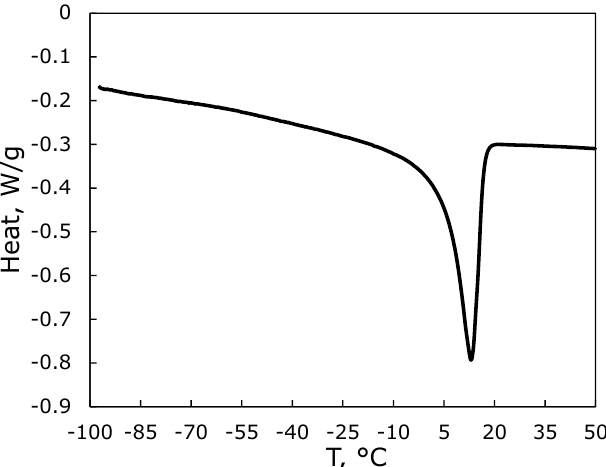
Figure 2. The DSC thermogram of poly(tetradecyl methyl siloxane).